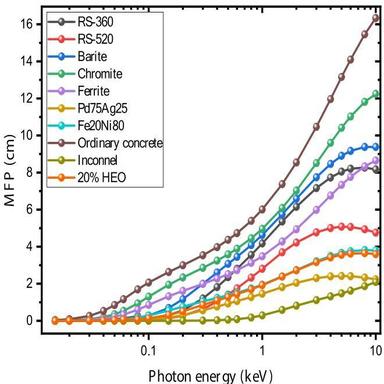
Comparison of MFP values of 20 % HEO sample with commonly used shielding materials.